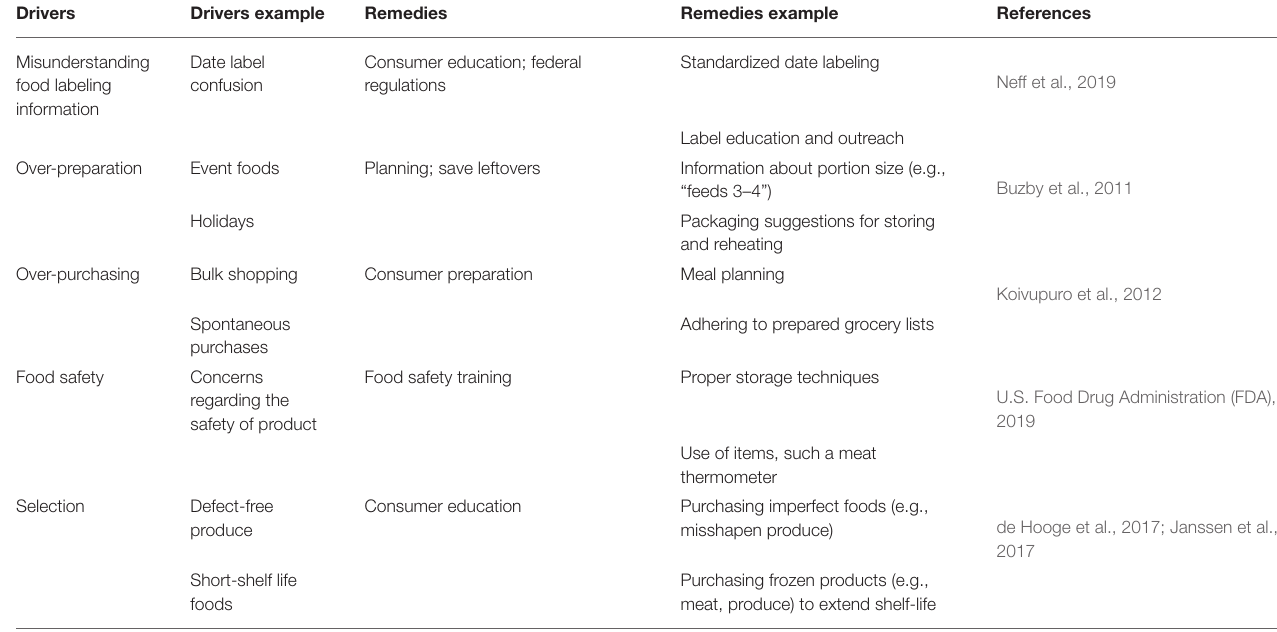
TABLE 3 | Food waste in the